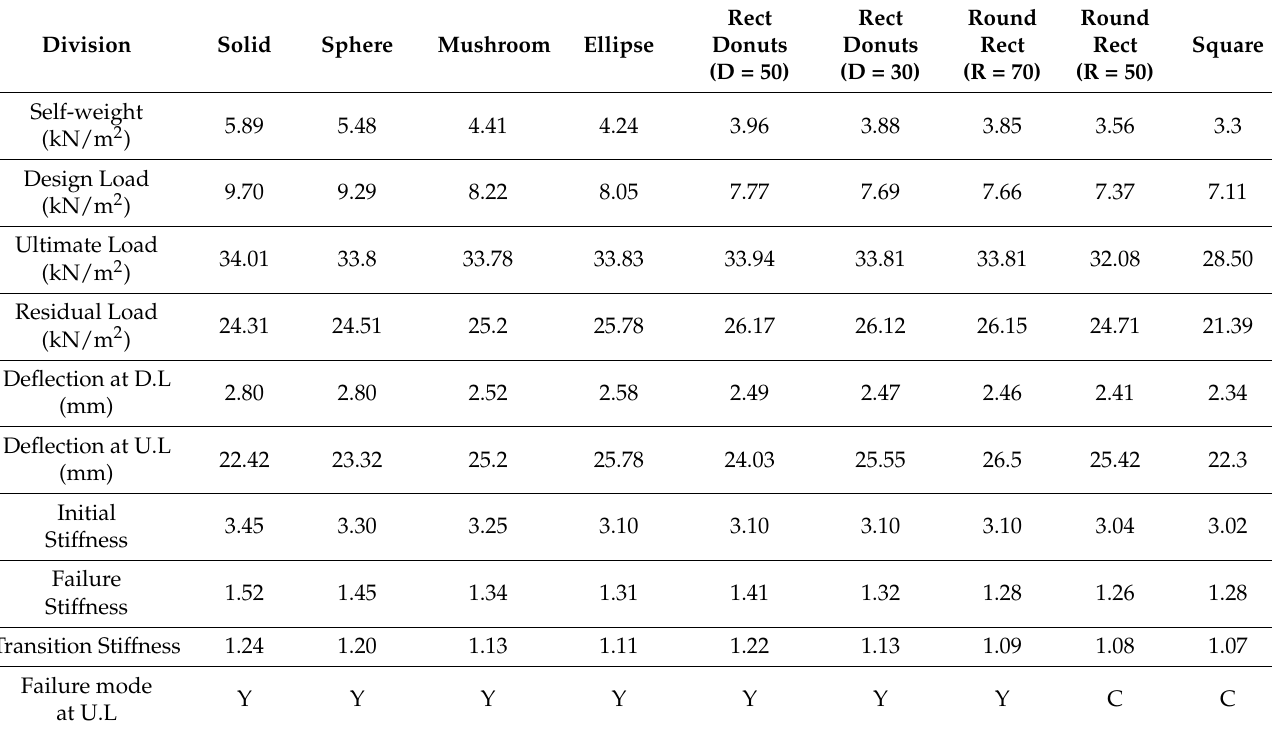
Table 4. The results of the FE